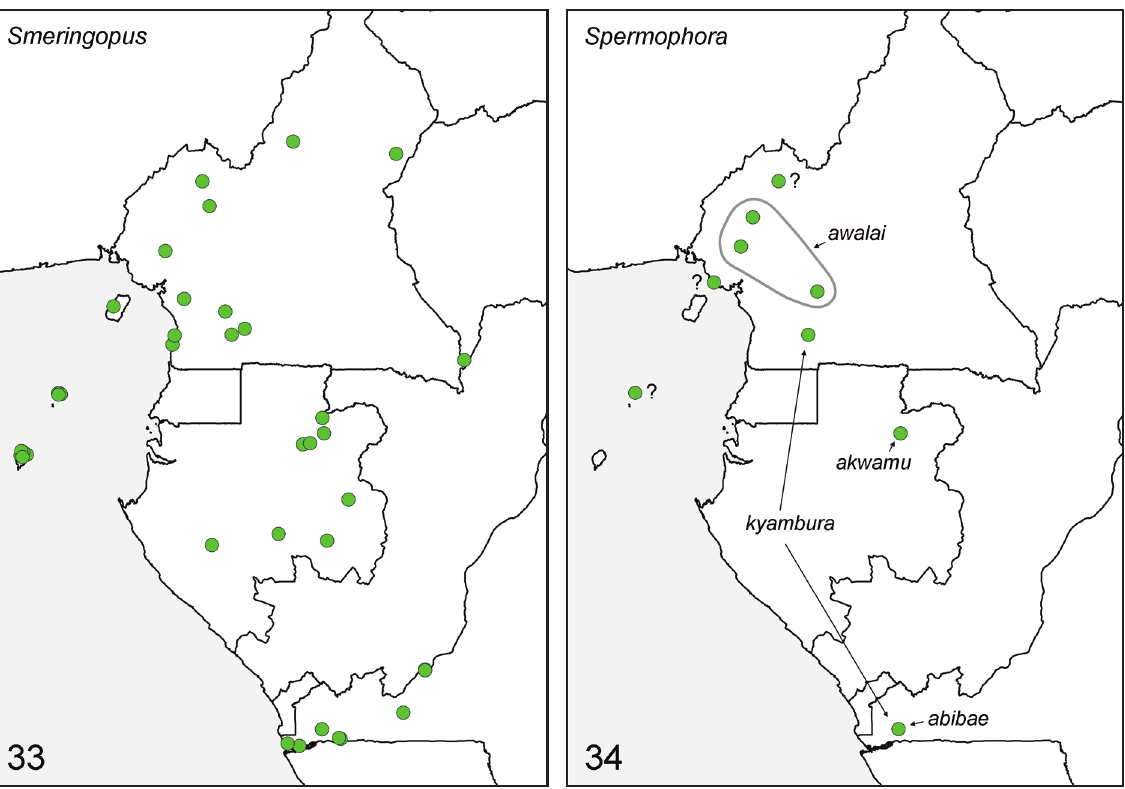
Figs 33-34. Known distributions of the genera Smeringopus Simon, 1890 and Spermophora Hentz, 1841 in Central Africa. For detailed distribution maps of Smeringopus species see Huber (2012). Question marks denote uncertain identifications (females from Cameroon; one pair from Príncipe